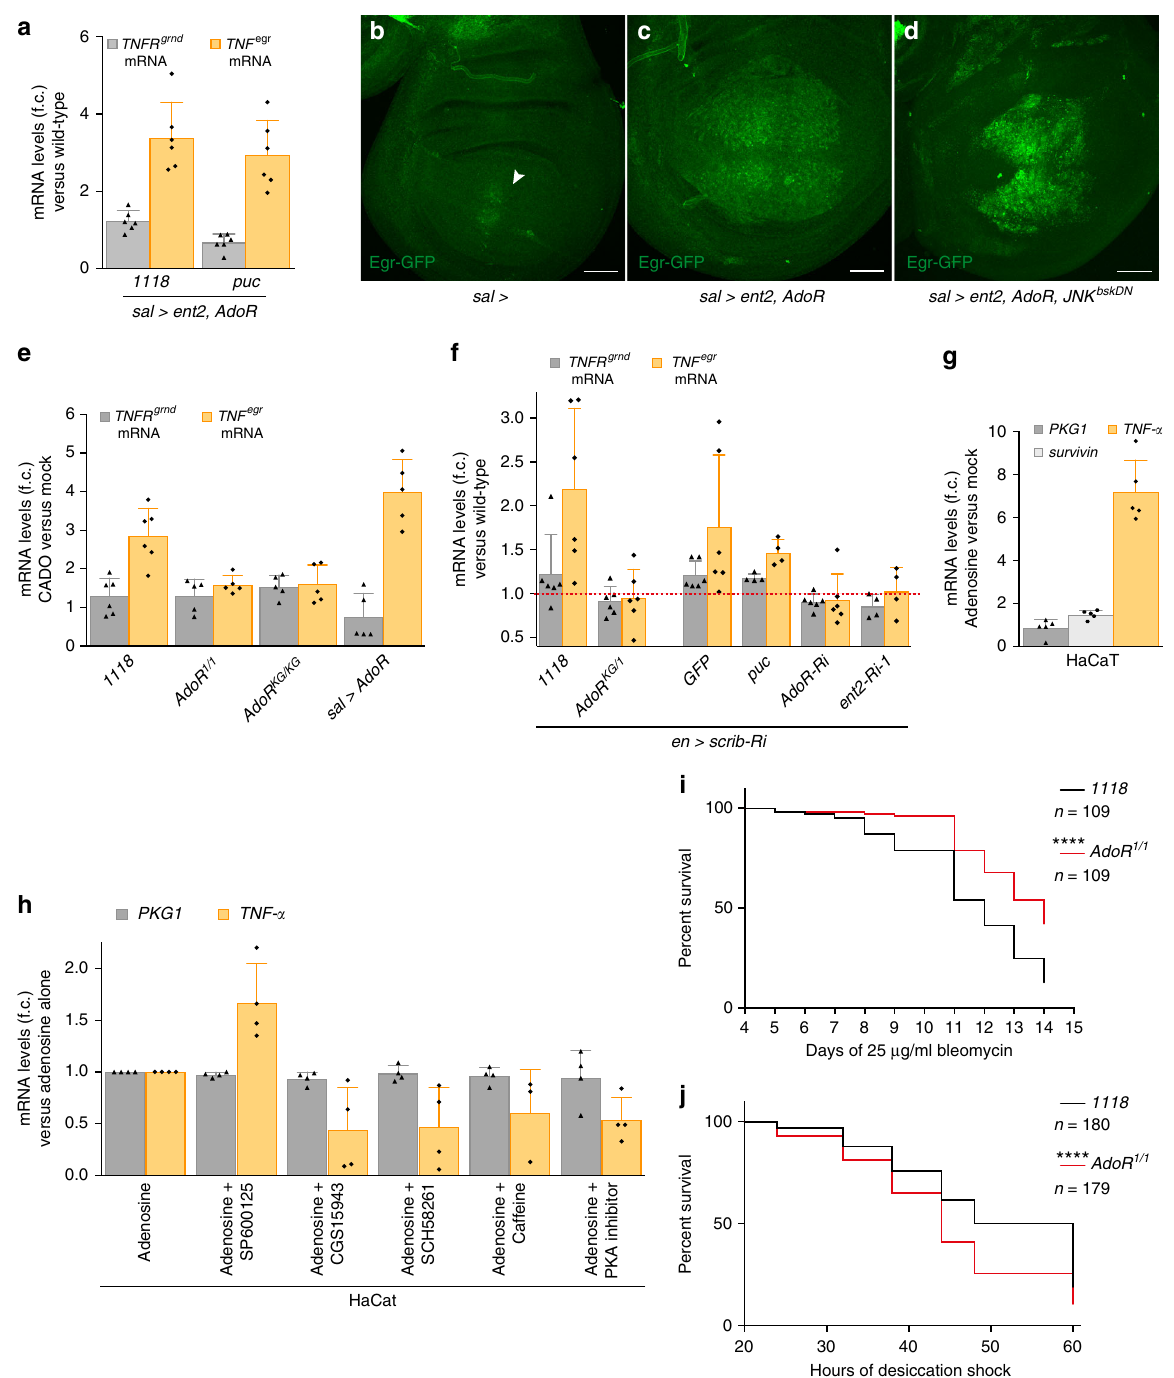
Fig. 4 AdoR promotes transcription of TNF Egr in polarity-de fi cient epithelial cells. a sal > ent2 , AdoR expression enhances TNF egr transcript levels in the wing disc independently of JNK signalling. TNFR grnd expression, measured by RT-qPCR, is shown as a control. Fold changes are relative to rp49 , n = 6. b – d sal > ent2, AdoR expression upregulates expression of Egr-GFP from a genomic fosmid ( b , c ). This effect is not rescued by co-expression of JNK bskDN ( d ). The arrowhead in b indicates a suspected position effect of the attP site (VK00033) where the fosmid was integrated. e CADO treatment increases expression of TNF egr in explanted wild-type discs, but not in AdoR mutant discs. This effect is further enhanced by Ador overexpression. TNFR grnd expression, measured by RT-qPCR, is shown as a control. Fold changes are relative to rp49 , n ≥ 5. f en > scrib Ri discs upregulate TNF egr mRNA in an AdoR/Ent2-dependent and JNK-independent fashion. Fold changes are relative to rp49 , n ≥ 4. g Human HaCaT cells treated with adenosine upregulates TNF- α transcript levels (as assayed by qRT-PCR). Fold changes are relative to GAPDH , n = 5. Expression of PKG1 , a housekeeping gene and survivin , a JNK target gene, are also shown. h The effect shown in g was suppressed by three different adenosine receptor antagonists (CGS15943, SCH58261 or Caffeine) and by a PKA inhibitor cocktail (Merck # 20-114), but not by JNK inhibitor SP600125. Fold changes are relative to GAPDH , n ≥ 3 and expression of PKG1 is shown. i , j AdoR mutants live longer than wild-type fl ies when continuously fed with a low dose of Bleomycin ( i ) but live shorter than wild-type fl ies during acute desiccation (dry starvation, j ). **** P < 0.0001, Gehan – Breslow – Wilcoxon test. Scale bars, 50 μ m. In graphs, means are shown, and error bars represent